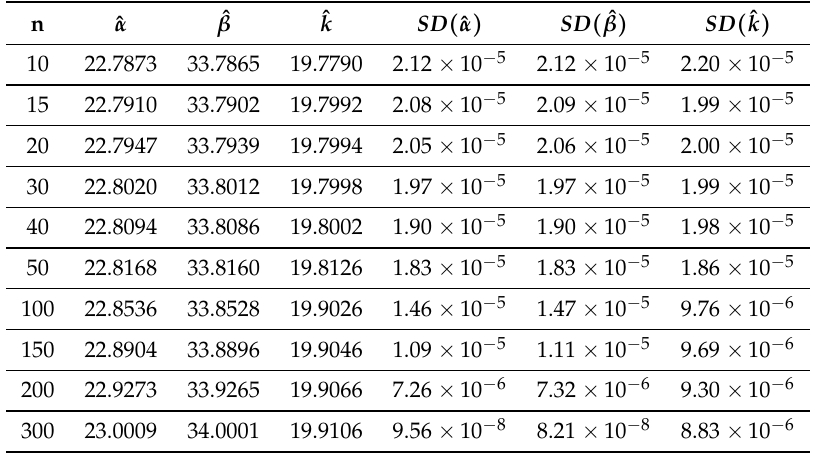
Table 2. Results of simulation with gradient method for m = 10,000 iterations, with α = 23, β = 34, k = 19, θ = 0.15.